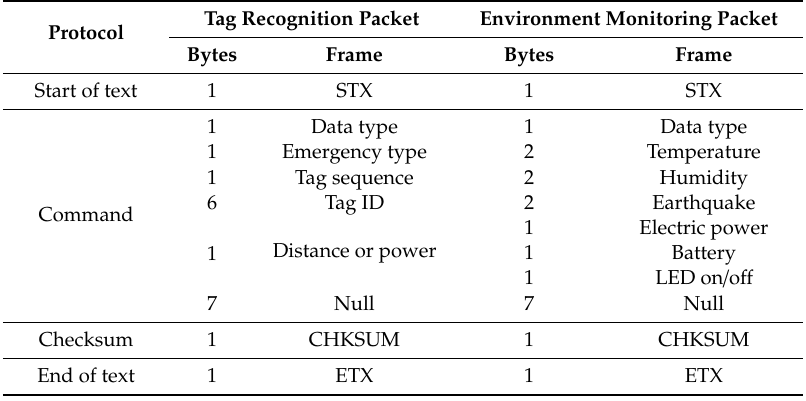
Table 1. Communication protocol frame of the packet data.